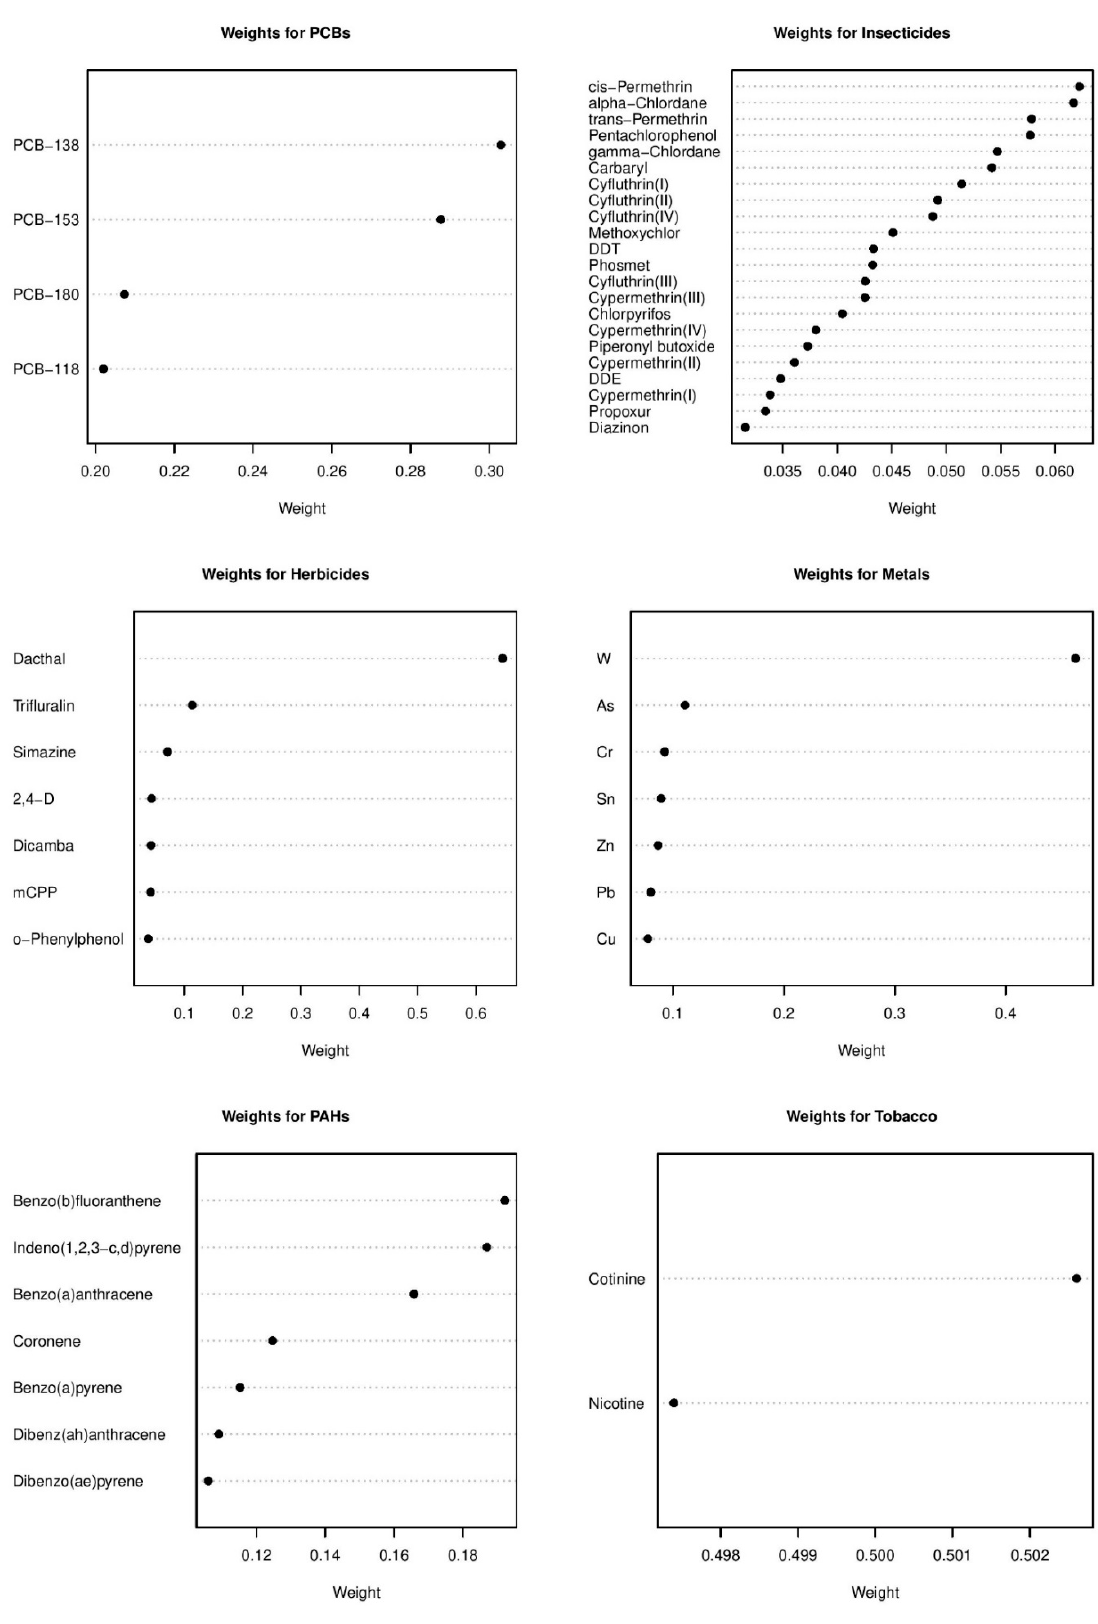
Figure 4. Estimated chemical weights for chemical groups from the Bayesian group index model for childhood leukemia in the CCLS in children with same residence since birth.